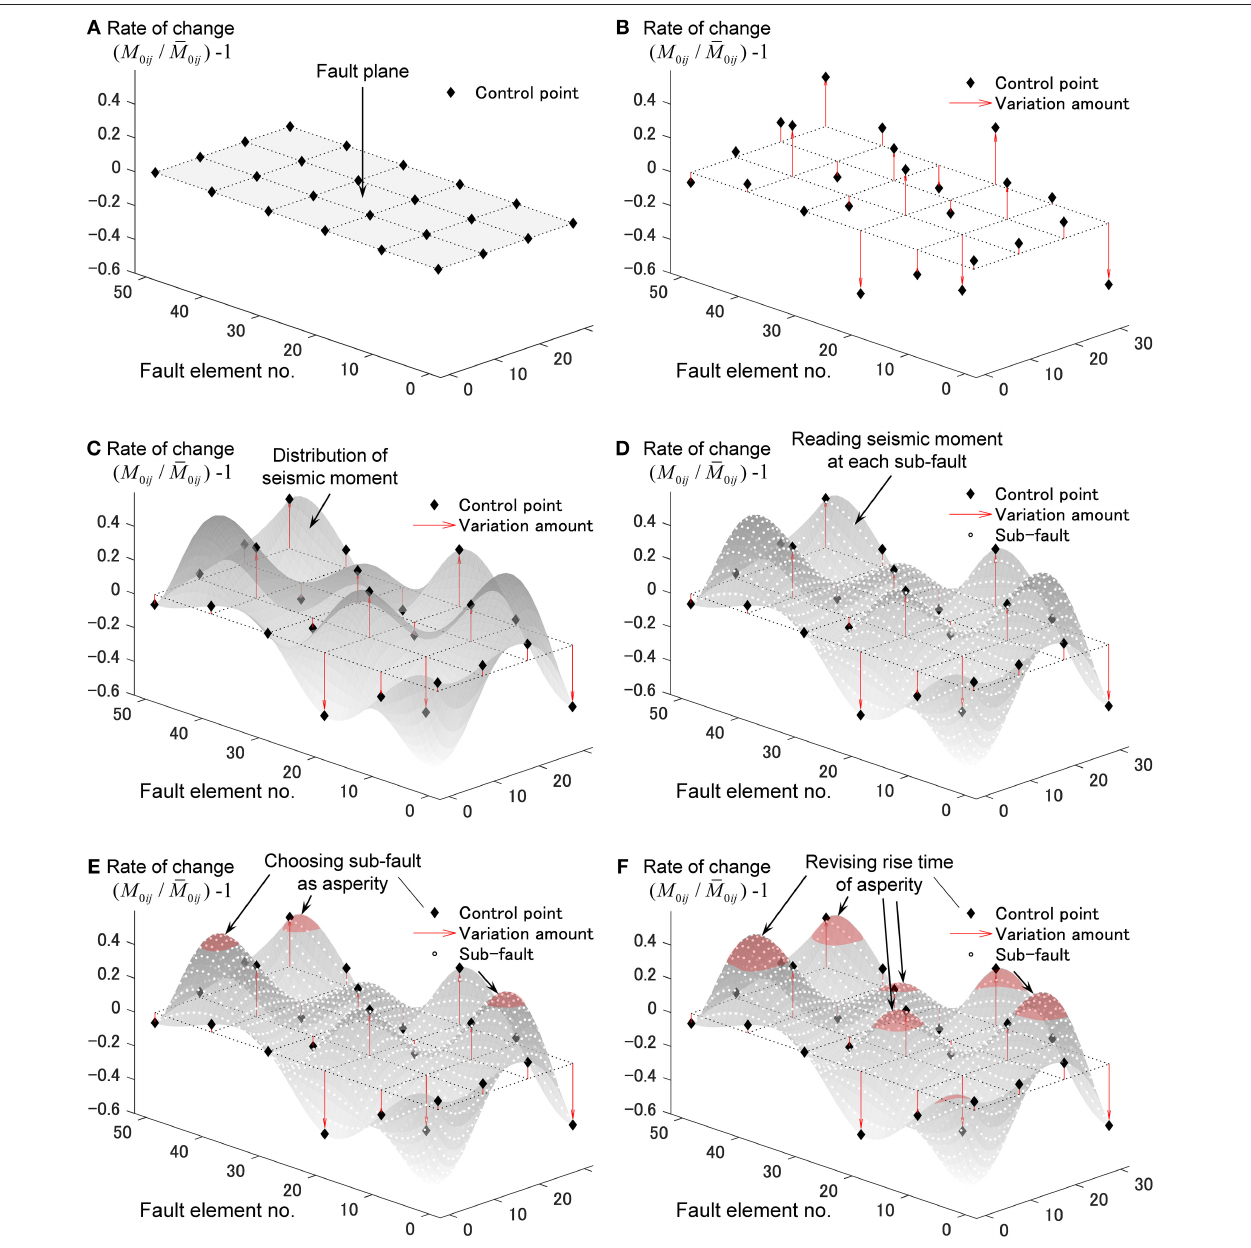
FIGURE 3 | Process of constructing critical fault model (variation of seismic moment in each fault element). (A) Setting of nominal model. (B) Variation of seismic moment at control point. (C) Interpolation of seismic moments at all points from values at control points. (D) Determination of seismic moments at all points by using bi-cubic spline function. (E) Set the asperity from the obtained seismic moment distribution. (F) Termination of assignment of seismic moment.